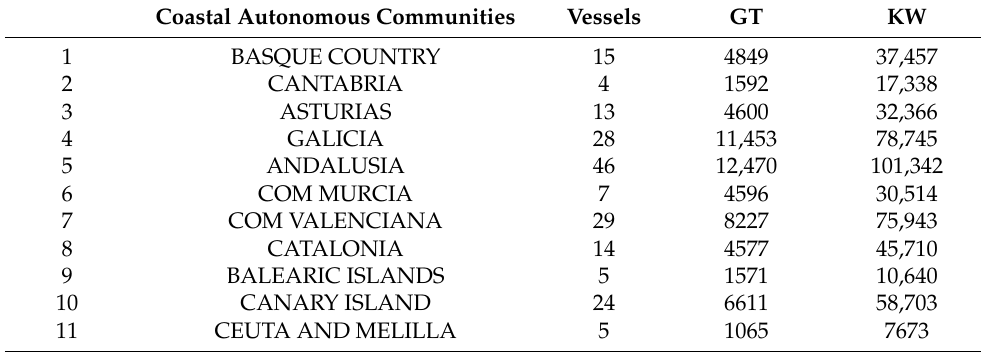
Table 2. Average data of the 14 years analyzed